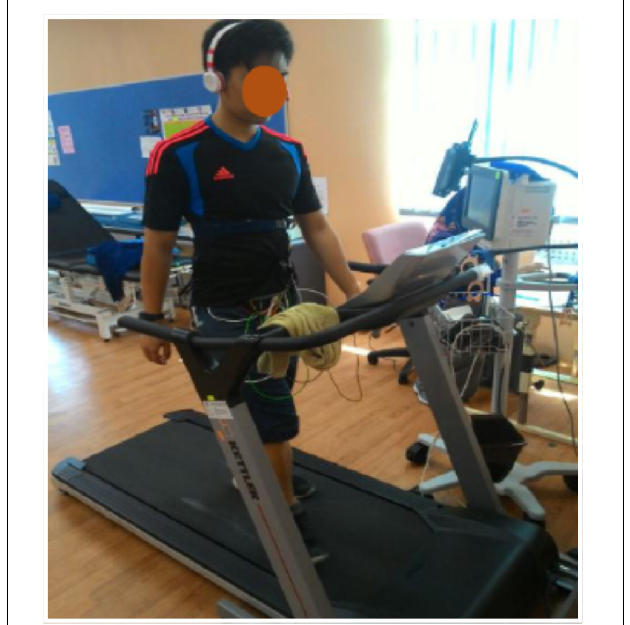
FIGURE 1 | A participant performs an incremental exercise on a treadmill until reaching the targeted heart rates at a predetermined percentage of the heart rate